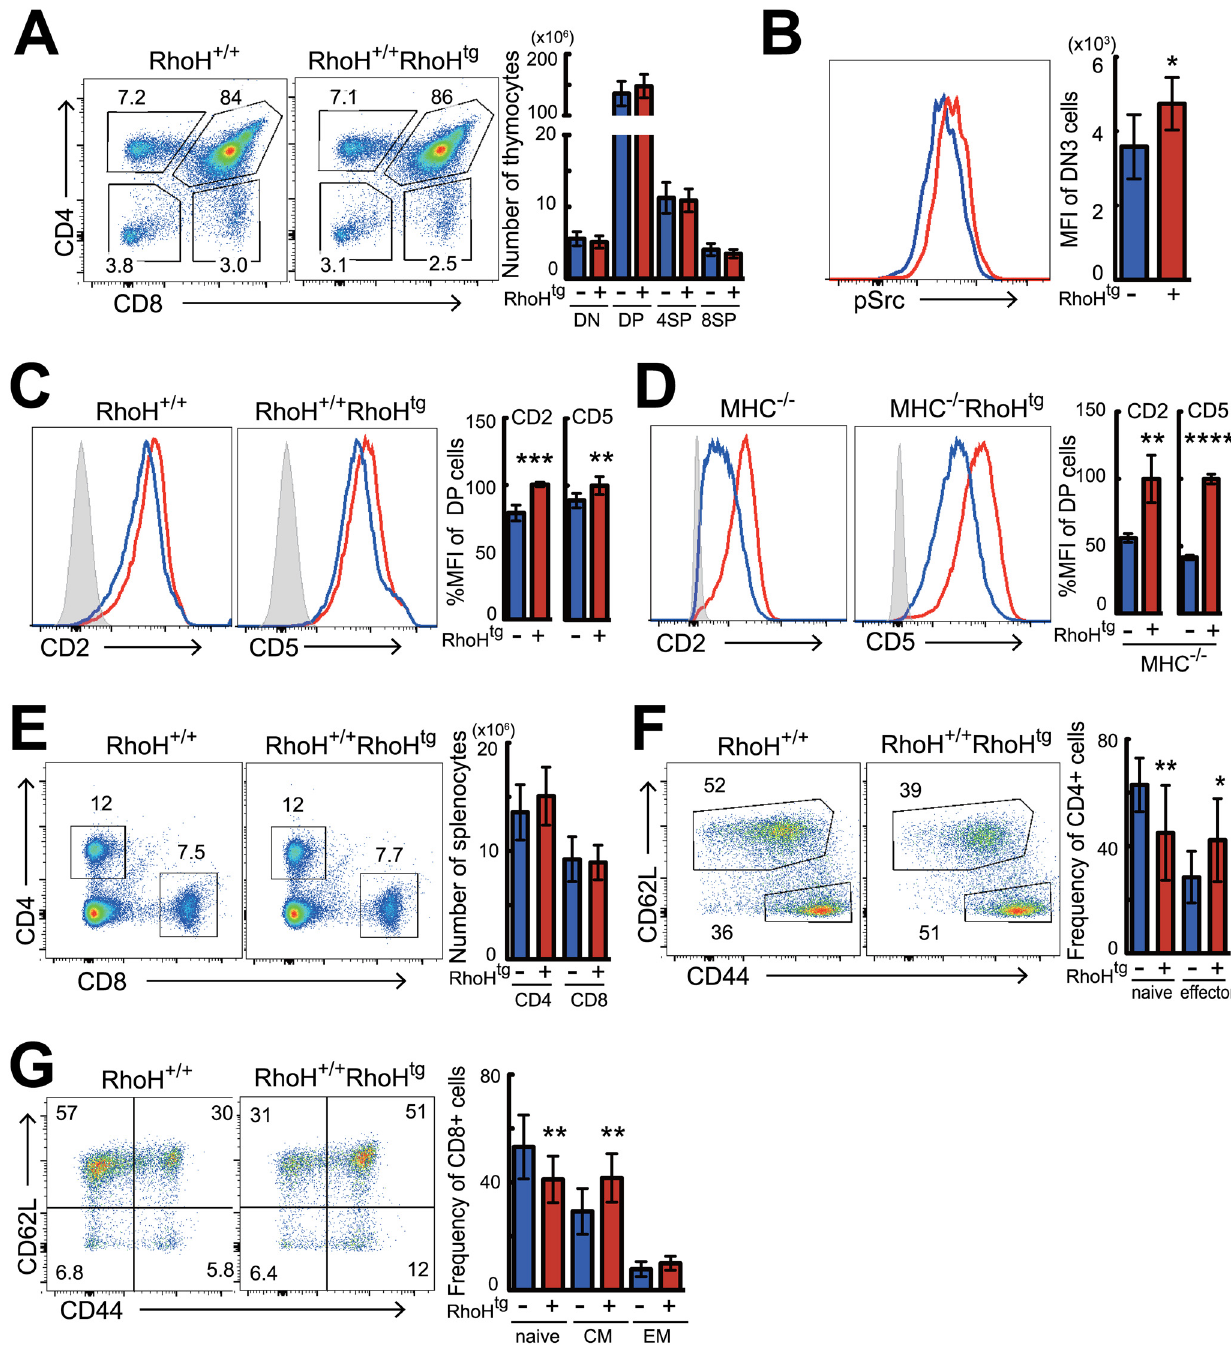
Fig 2. Analysis of T cell development in RhoH overexpressing mice. Analysis by flow cytometry of thymocytes and splenocytes from RhoH +/+ RhoH Tg (red) and RhoH +/+ (blue) mice. Representative two parameter plots show CD4 versus CD8 staining on thymocytes (A, n = 8) and splenocytes (E, n = 13). (B) Representative single-parameter histogram plots show intracellular staining of Phospho-src (pY416) gated on CD4 - CD8 - CD44 - CD25 + (DN3) cells (n = 5). Representative single-parameter histogram plots show cell surface staining of CD2 and CD5 antigens on DP cells from RhoH +/+ RhoH Tg and RhoH +/+ mice in either MHC +/+ (C, n = 6) or MHC -/- (D, n = 5) background. Solid line and dashed line represent RhoH +/+ and RhoH +/+ RhoH Tg , respectively. (F, G) Flow cytometric analysis of CD44 versus CD62L expression profile on splenic CD4 + T (F) or CD8 + T (G) cells gated on TCR β + T cells (n = 10). Data are shown as mean +SD and samples were from more than four independent experiments. ** P < 0.01, *** P < 0.001, **** P < 0.0001.